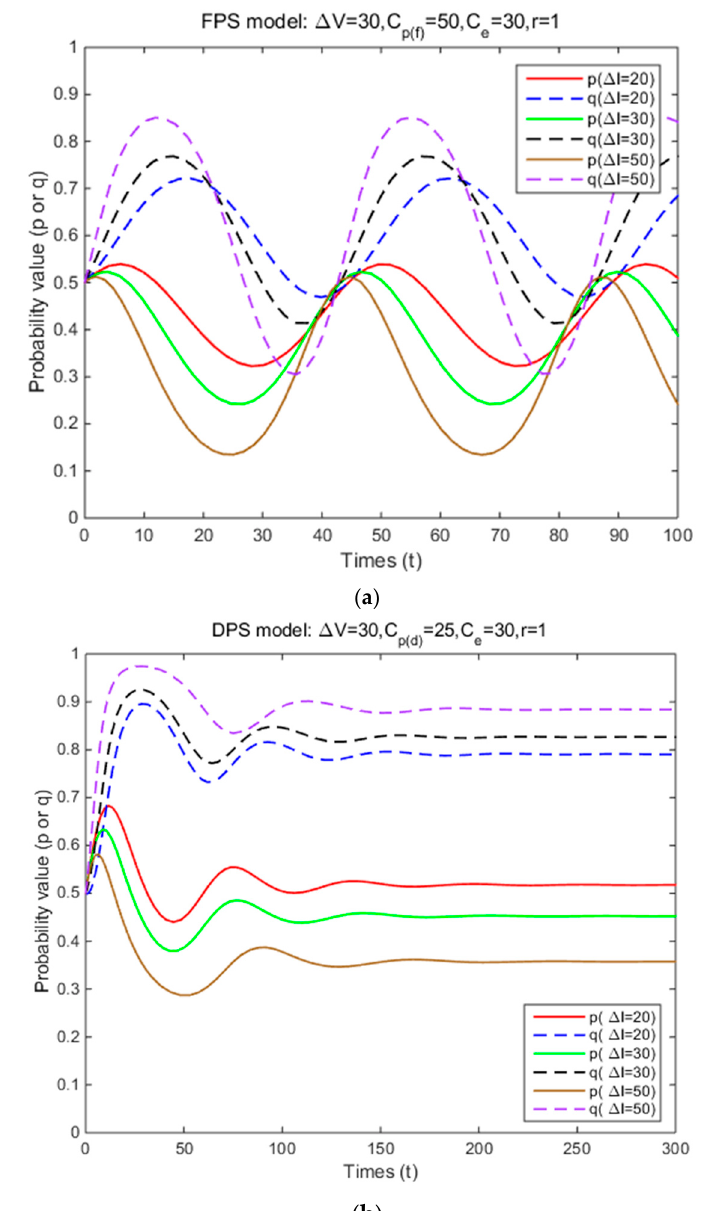
Figure 10. The effects of relative public image cost on strategy probabilities of cyclists and law enforcement under FPS ( a ) and DPS ( b ) (Situation 3).